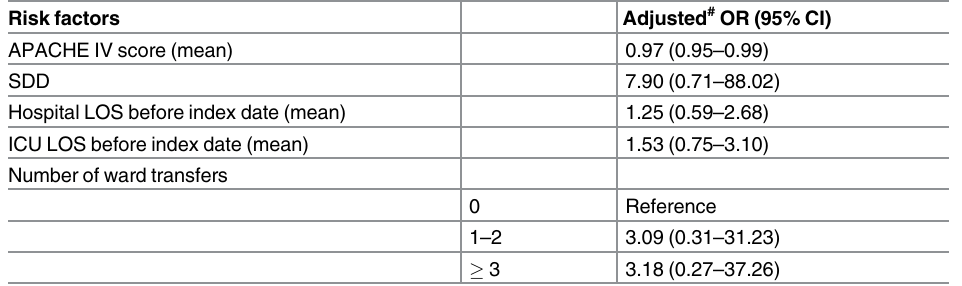
Table 5. Adjusted odds ratios of risk factors for CDI ribotype 027 in participants who had stayed at the